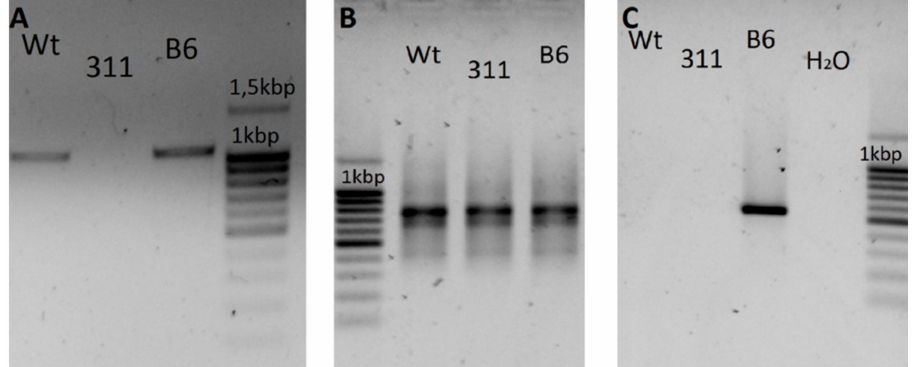
Figure 5. PCR results with primers to the tobacco genomic DNA flanking transgenic inserts. Sample Wt—DNA of non-transgenic tobacco plant, samples 311 and B6—DNA of transgenic plants of lines Inter311 and InterB6. ( A ): primers 311_L1 + 311_R1. The corresponding fragment (1093 bp) is absent in sample 311, in which the T-DNA was inserted between the binding sites of these primers. ( B ): primers B6_L2 + B6_R1. High level of non-specific binding was shown for all samples, which confirms the insertion of the T-DNA into the region of repeats. ( C ): primers B6_R1 (tobacco